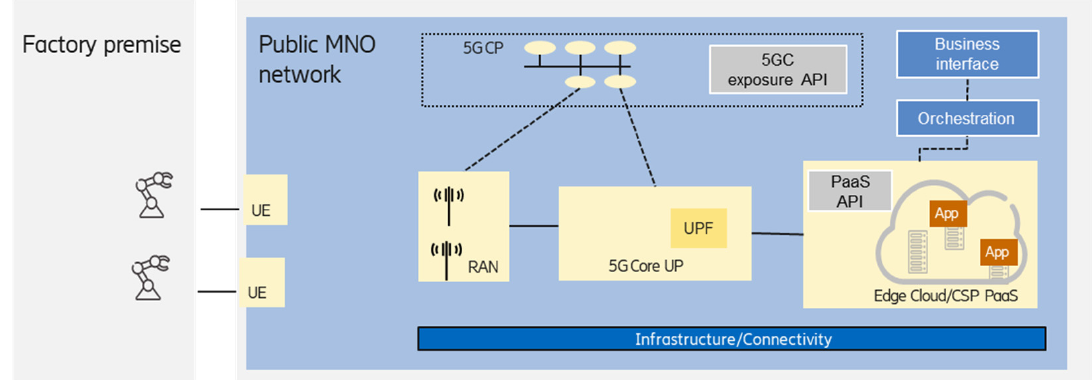
Figure 6. Edge computing service and PNI-NPN offered by MNO.